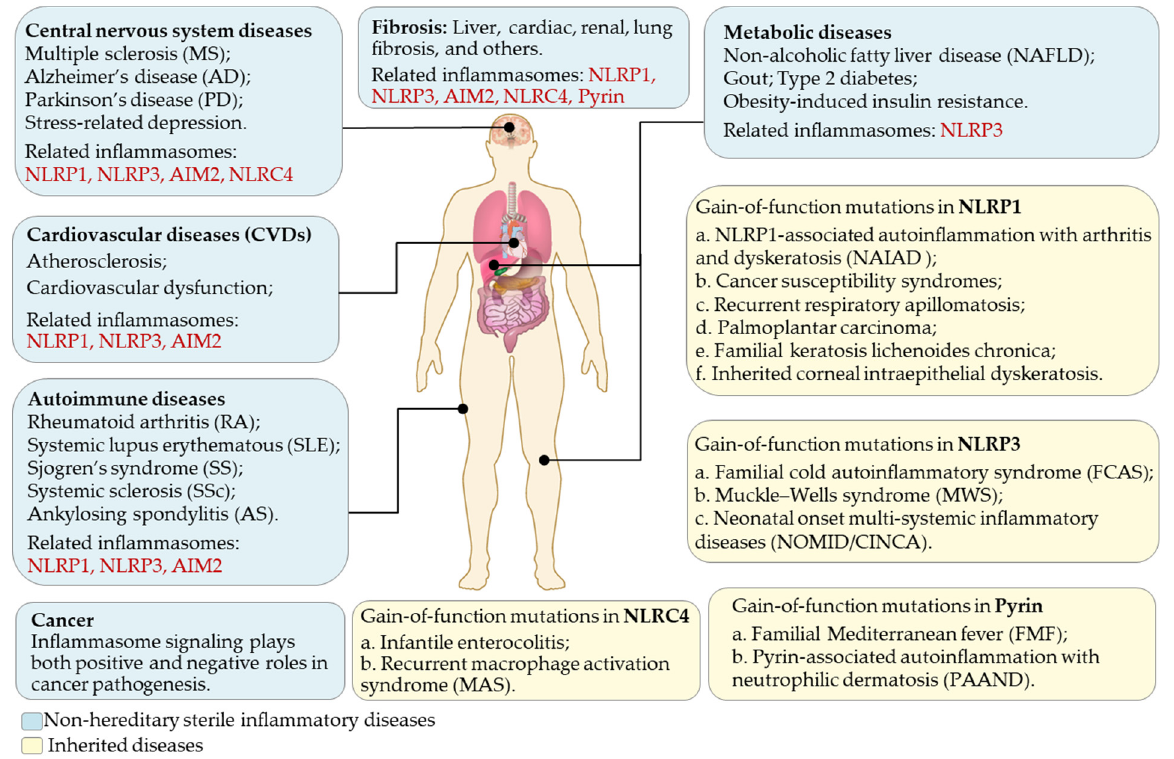
Figure 4. Inflammasome-related human diseases. Canonical inflammasomes are involved in multiple inherited diseases (yellow-shaded boxes) and non-hereditary sterile inflammatory diseases (blue-shaded boxes). The highly relevant inflammasomes responsible for sterile inflammatory diseases are labeled in red.